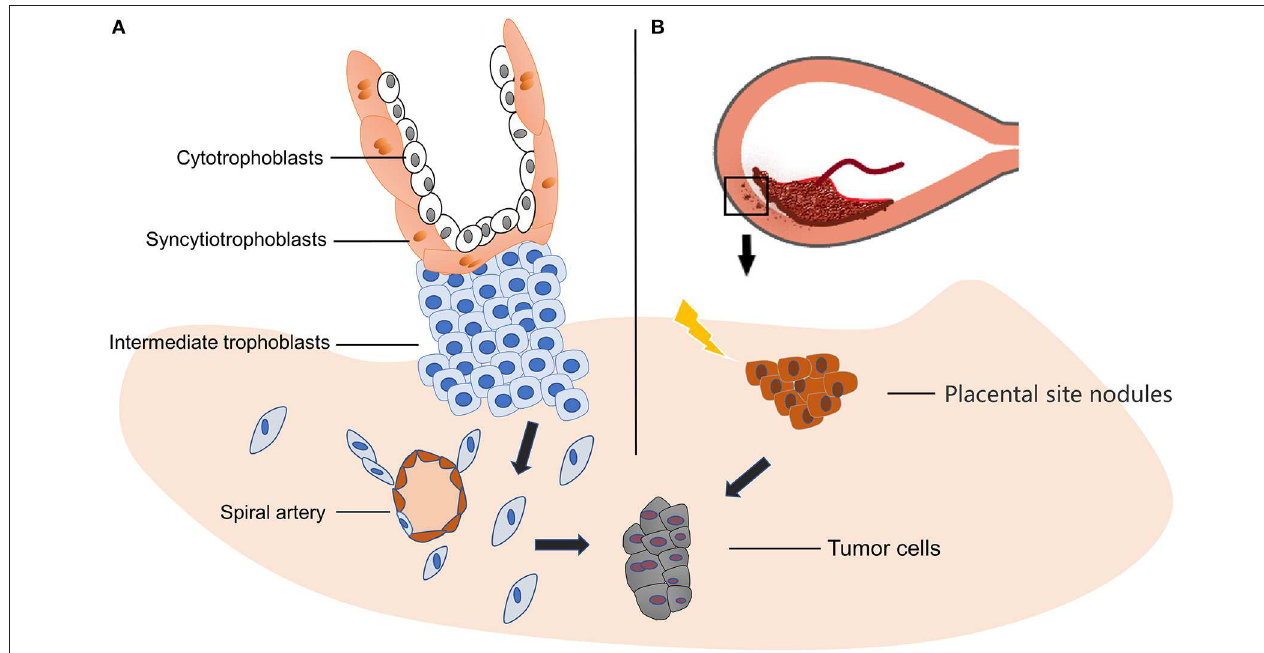
FIGURE 1 | Origin of PSTT. (A) PSTT originates from extravillous trophoblasts, and then acquires the abilities of proliferation and migration. Afterwards, those cells migrate away from placenta and invade the decidual artery and uterine spiral artery to remodel the blood vessels which in turn provide nutrition for the embryo. The disruption of this well-regulated invasion process may lead to PSTT. (B) During delivery, placenta detaches from decidual, leaving small nodules and form placental site nodules in the myometrium. In the process of reabsorbing, some adverse trigger or stimuli may cause atypical mitosis and result in